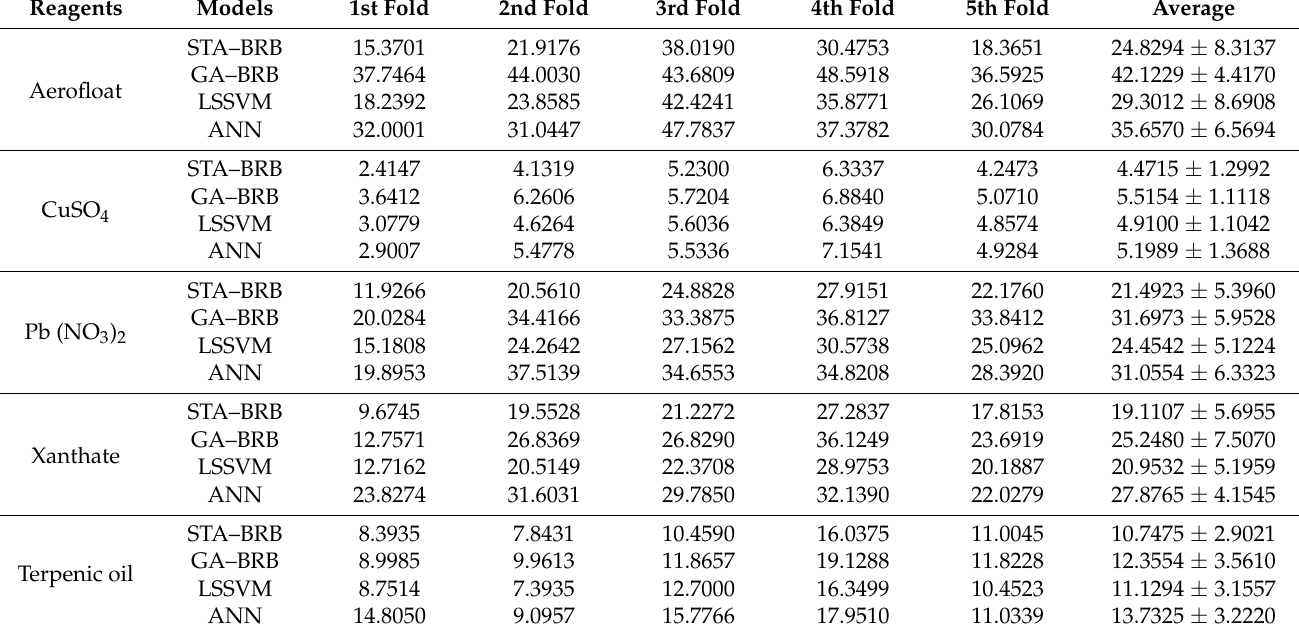
Table 11. The errors between calculated reagent addition and actual reagent addition, set